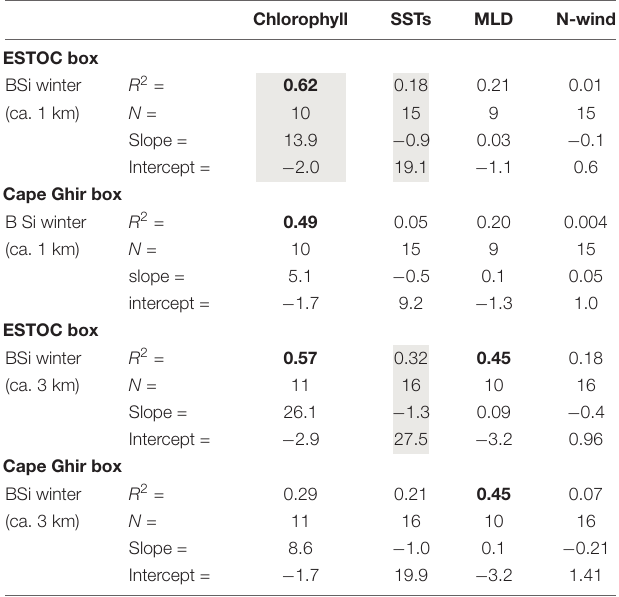
TABLE 1 | Regression parameters of mean winter BSi fluxes measured at 1 km and 3 km depth vs. the environmental variables from both boxes. Chlorophyll SSTs MLD